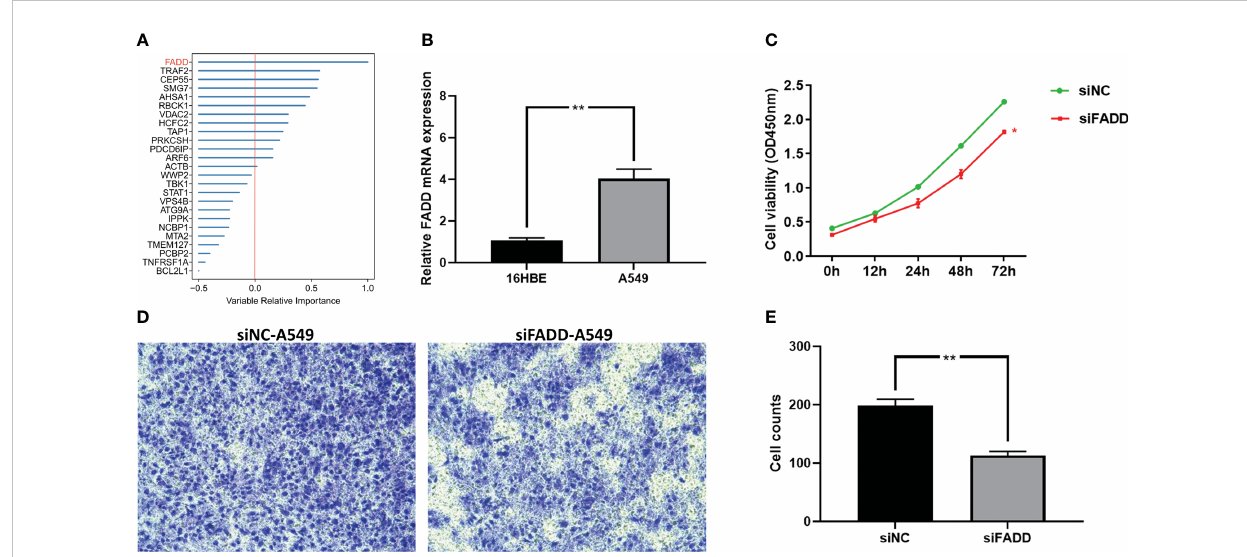
FIGURE 11 Validation the malignancy of FADD by cellular experiments (A) Random forest shows that FADD is the most important variable. (B) Differential mRNA expression levels of FADD in 16HBE and A549 cell lines by qPCR. (C) Cell proliferation of A549 cells transfected with FADD siRNA or siNC.